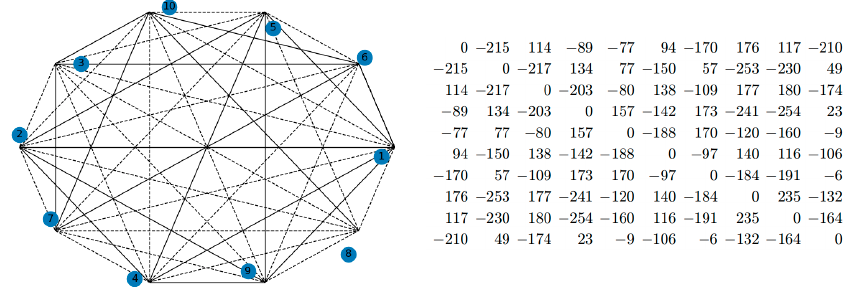
Figure 9. Nodes distribution of the 𝛾 -Quasi-Cliques with different 𝛾 . ( a ) is the distribution of 𝛾 - Quasi-Cliques when the 𝛾 = 0.6; ( b ) is the distribution of 𝛾 -Quasi-Cliques when the 𝛾 = 0.7; ( c ) is the distribution of 𝛾 -Quasi-Cliques when the 𝛾 = 0.8; ( d ) is the distribution of 𝛾 -Quasi-Cliques when the 𝛾 = 0.9; ( e ) is the distribution of 𝛾 -Quasi-Cliques when the 𝛾 = 1.